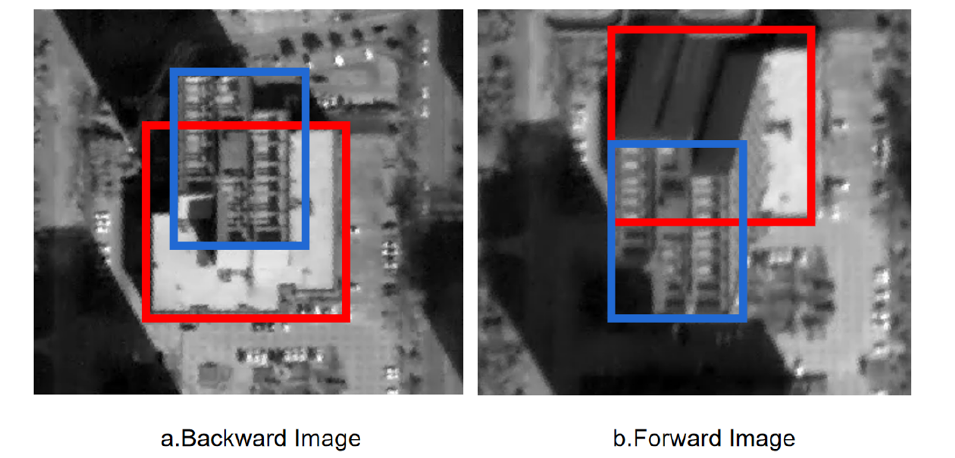
Figure 7. Backward and forward view of a podium building. ( a ) podium on backward image; ( b ) podium on forward